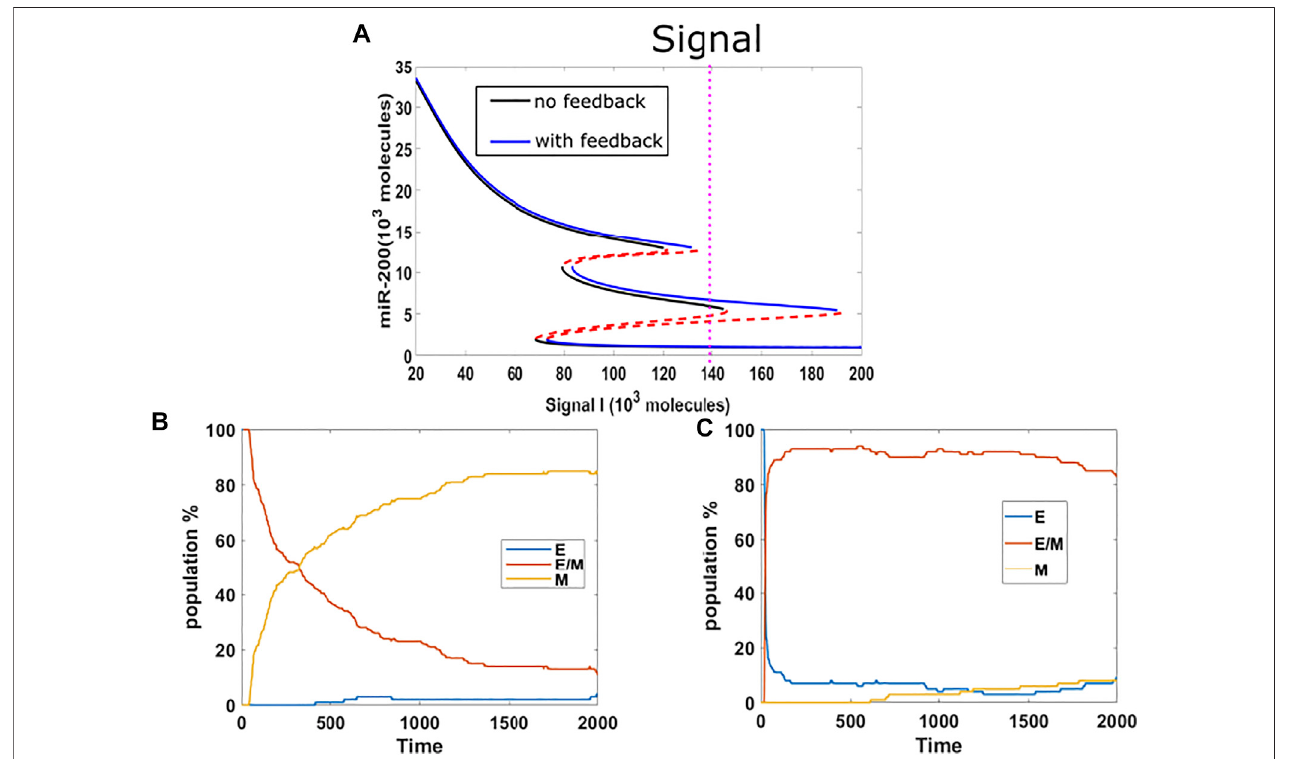
FIGURE 3 | (A) Bifurcation results (black lines represent no feedback, blue lines represent feedback on NRF2 ’ s inhibition on SNAIL, and the mean of signal is fi xed at 140 K (purple dotted line). (B) Population analysis without epigenetic feedback for 100 cells. (C) Population analysis with epigenetic feedback for 100 cells.